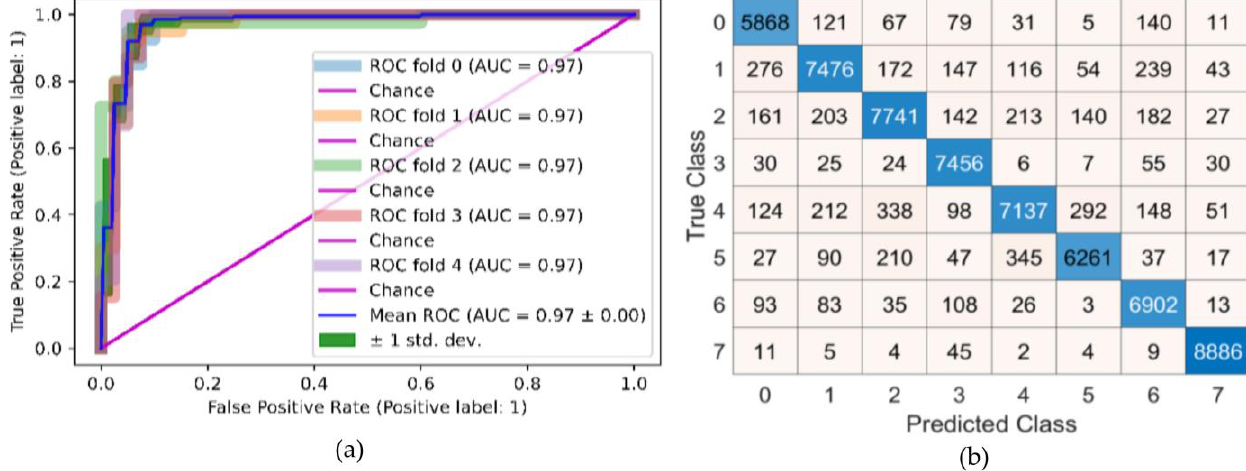
Table 11. Classification results on ISIC 2019 dataset.